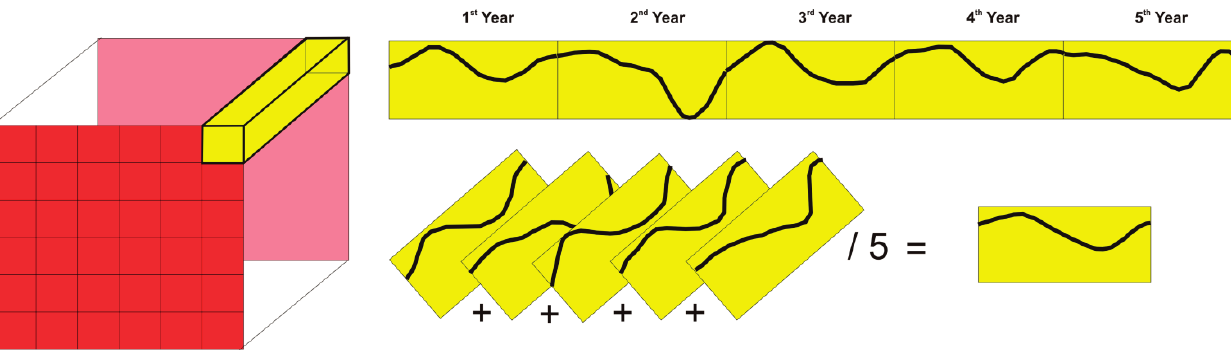
Figure 7. Procedure for calculating interannual mean curve, considering a pixel and five-year